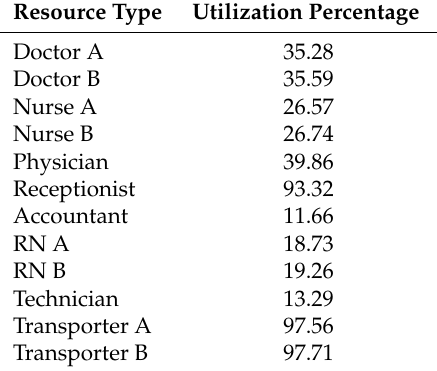
Table 4. Resource